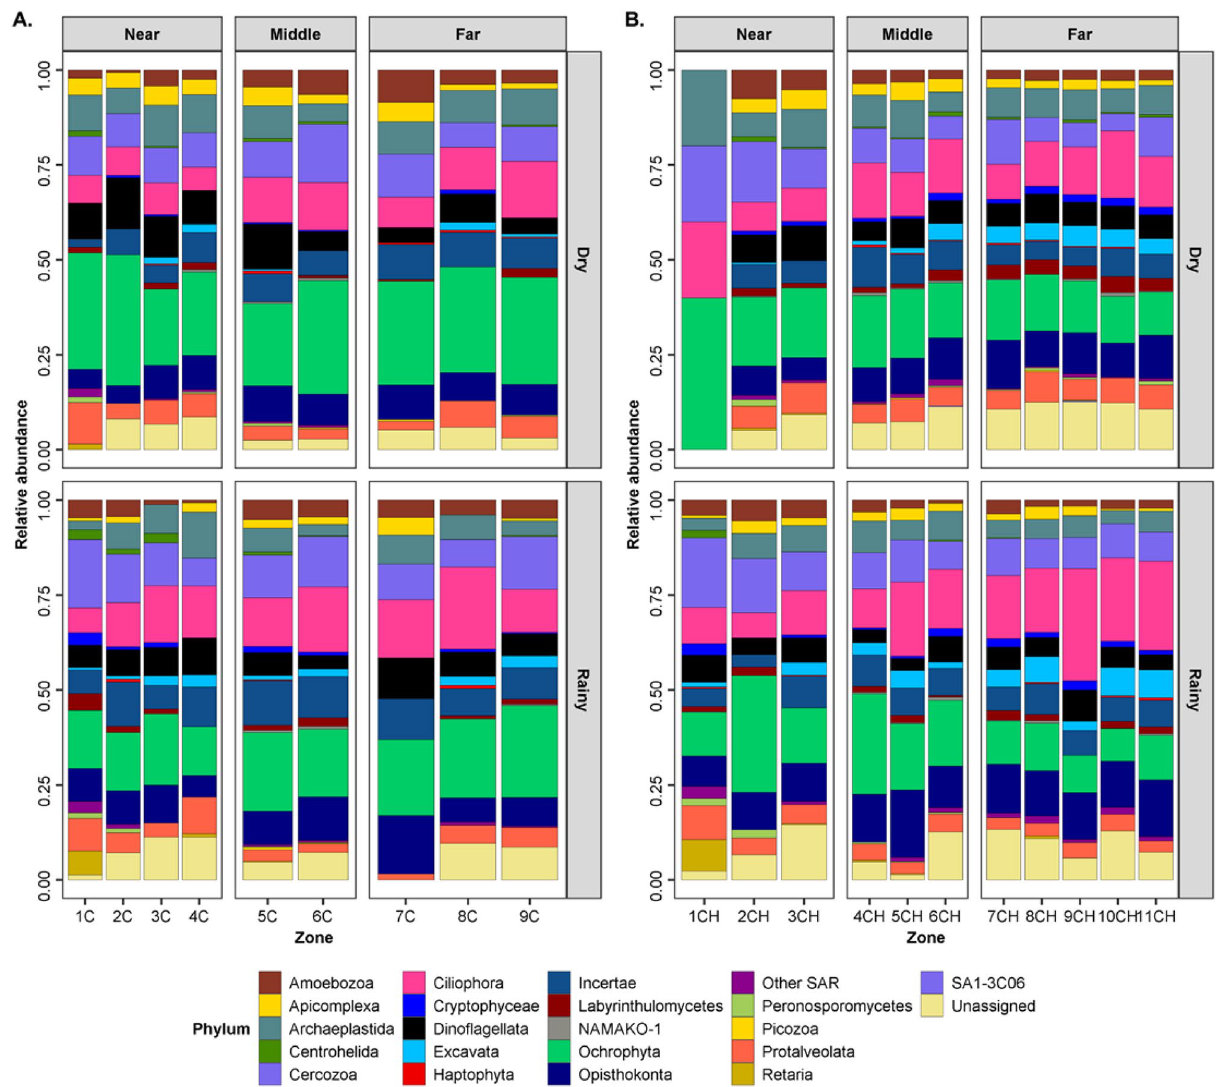
Figure 3. Relative abundance of MOTUs of microeukaryotic phyla in 18S-V4 amplicon sequence libraries generated from sediments collected from Chacahua-Pastoria and Corralero-Alotengo lagoon systems throughout seasons, regions and lagoon zones. ( A ) C: Corralero-Alotengo Dry and Rainy seasons. Regions in the lagoon systems (distance to the mouth), N: Near (Zones: 1, 2, 3, 4), M: Middle (Zones: 5, 6) and F: Far (Zones: 7, 8, 9). ( B ) CH: Chacahua-Pastoria Dry and Rainy seasons. Regions in the lagoon systems (distance to the mouth), N: Near (Zones: 1, 2, 3), M: Middle (Zones: 4, 5, 6) and F: Far (Zones: 7, 8, 9, 10,